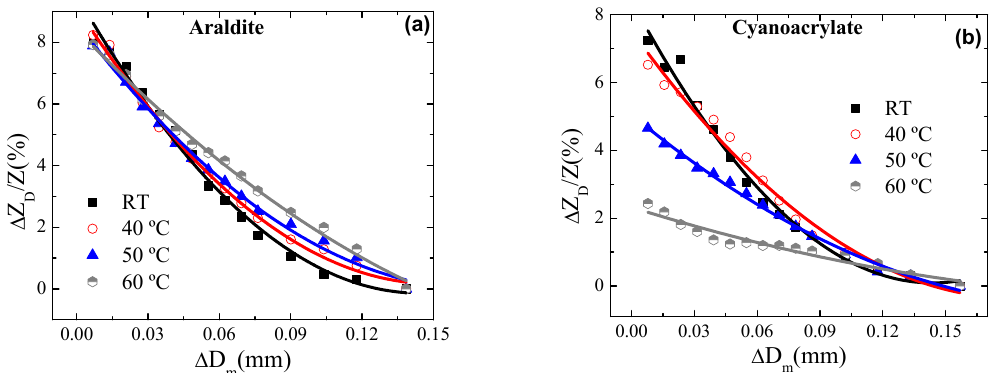
∆ Z ( % ) , as a function of the induced variations in probe D Z ∆(cid:3027) (cid:3253) (%) , as a function of the induced variations in (cid:3027)